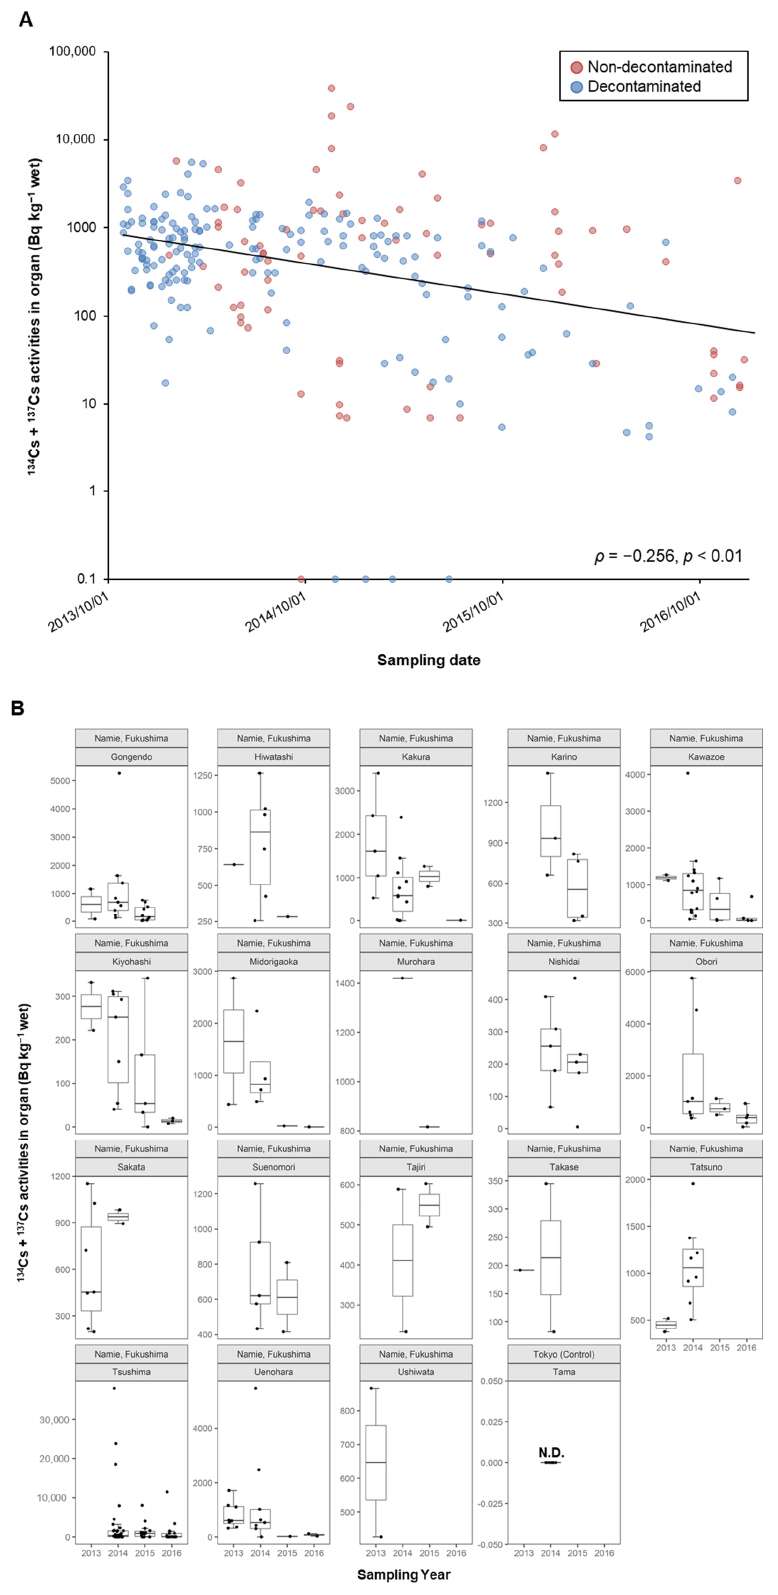
Figure 3. Change in 134 Cs + 137 Cs activity concentrations in reproductive organs of cats, with respect to ( A ) date caught and ( B ) area caught. In panel ( B ), each boxplot represents its distribution and black dots shows individual 134 Cs + 137 Cs activity concentrations in reproductive organs. N.D.; not detected. There was also no clear correlation between the areas of where the cat was captured (ambient dose-rates and 134 Cs + 137 Cs activity concentration in soil) and 134 Cs + 137 Cs activity concentration in the reproductive organs of cats (Figure 4).